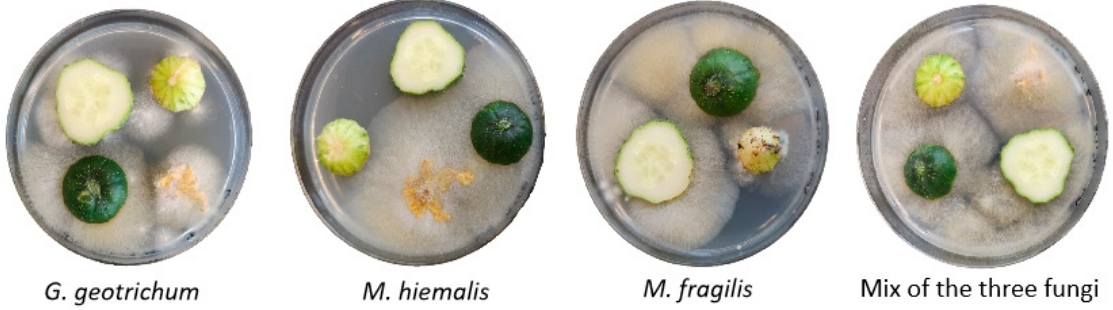
Figure 5. Fungal growth on inoculated fresh gherkins. Open gherkin blossoms were sprayed with spore suspensions of the fungi Galactomyces geotrichum , Mucor hiemalis , Mucor fragilis, or a mixture of the three fungi. Gherkin slices and blossoms placed on PDA showed fungal growth corresponding to the respective inoculum.